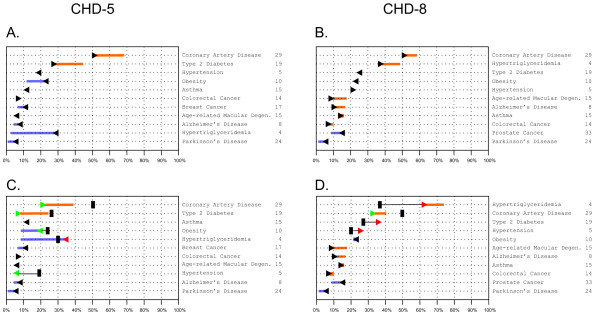
(A,C) Risk-o-gram plots for common diseases in standard format for two individuals, (A) CHD-5 and (B) CHD-8. (C,D) Risk-o-grams adjusted according to observed clinical risk for (C) CHD-5 and (D) CHD-8. Gender and age-specific disease prevalence for Caucasians are indicated by the black triangles (or hash marks in lower panels). Genotypic effects are predicted to increase (right point) or decrease (left point) overall risk by the indicated magnitude (orange or purple, respectively), resulting in the indicated rank-ordered overall risk. The number of single-nucleotide polymorphism (SNPs) used in the computation for each disease is indicated to the right. (C,D) The adjusted risk-o-grams according to observed clinical risk either increase (red triangle) or decrease (green triangle) the baseline without affecting the genotypic component, but result in adjustment of overall risk and rank order. Note that CHD-5 is a woman, and CHD-8 a man, so breast and prostate cancer are indicated for each as appropriate.